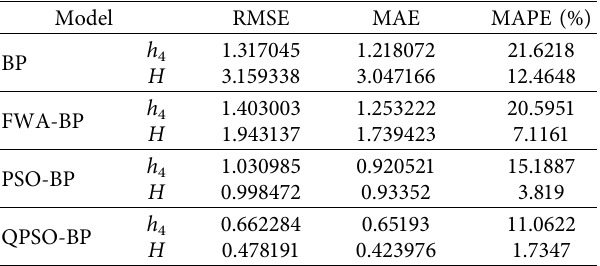
Table 3: Statistical tests of the different models.